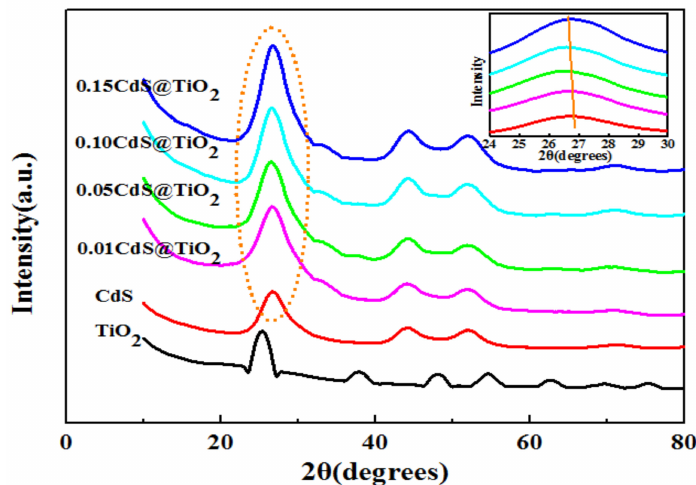
Figure 1. XRD patterns of CdS, TiO 2 and CdS@TiO 2 composites; the inset shows the magnified XRD patterns CdS@TiO 2